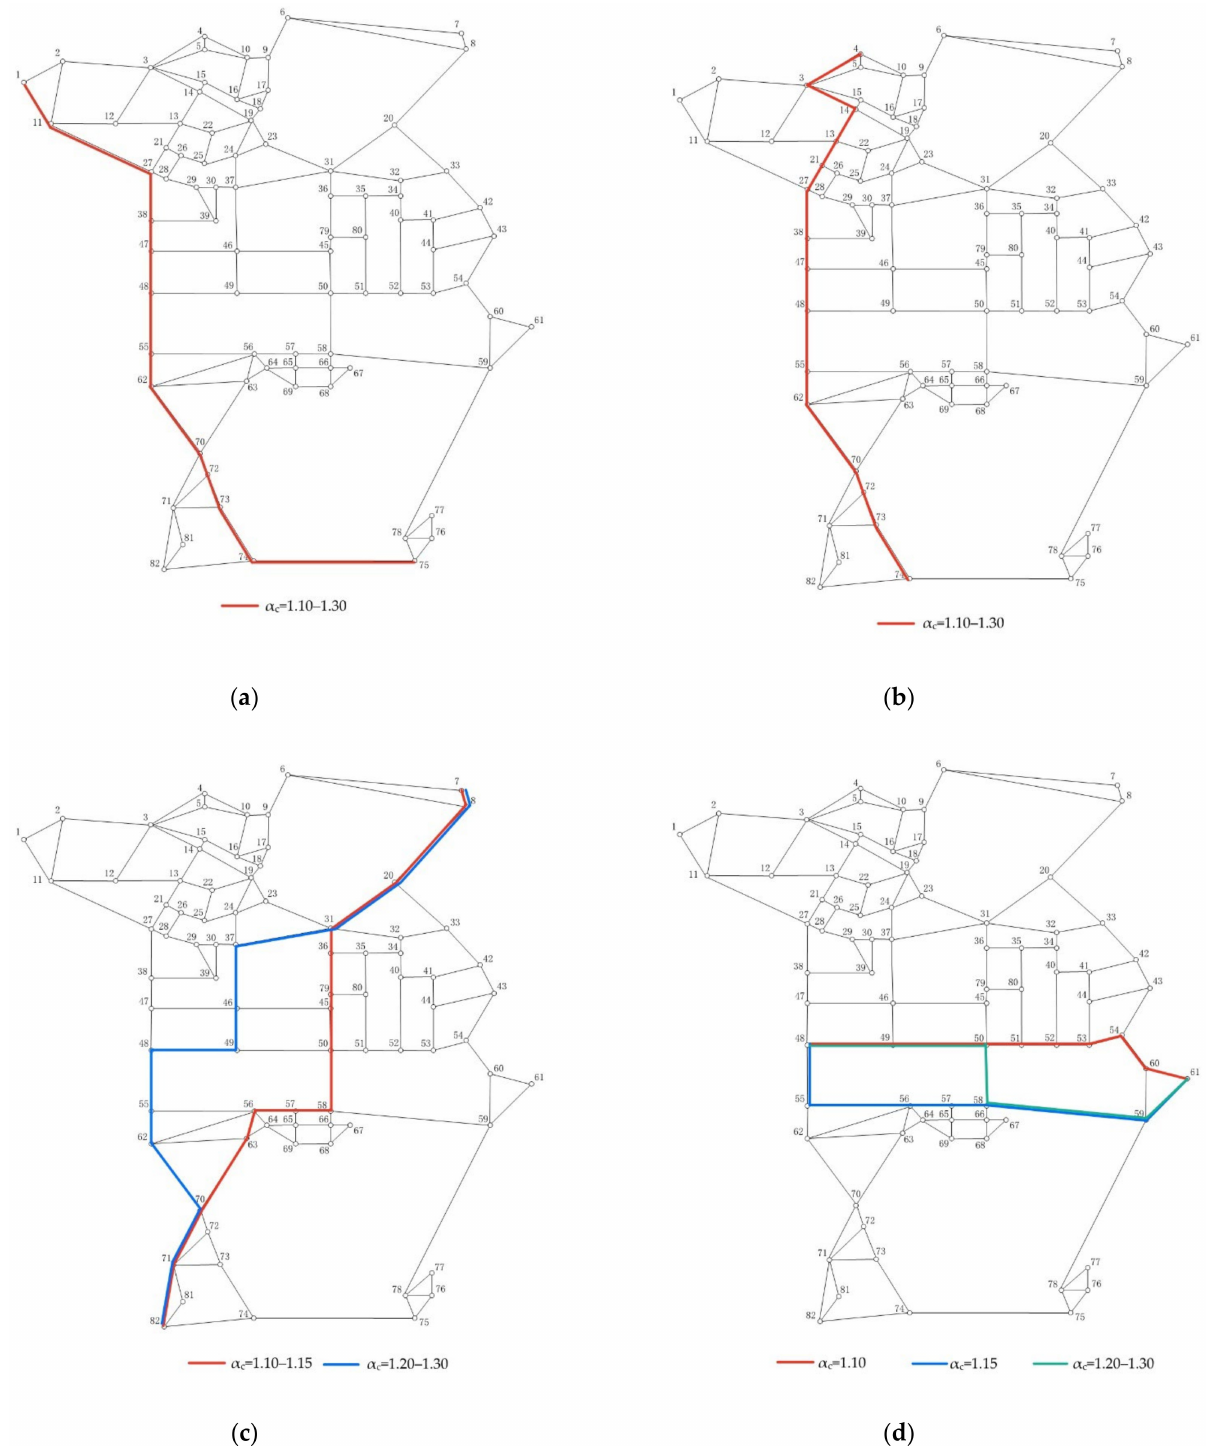
Figure A1. ( a ) The route from points 1 to 75. ( b ) The route from points 4 to 74. ( c ) The route from points 7 to 82. ( d ) The route from points 48 to